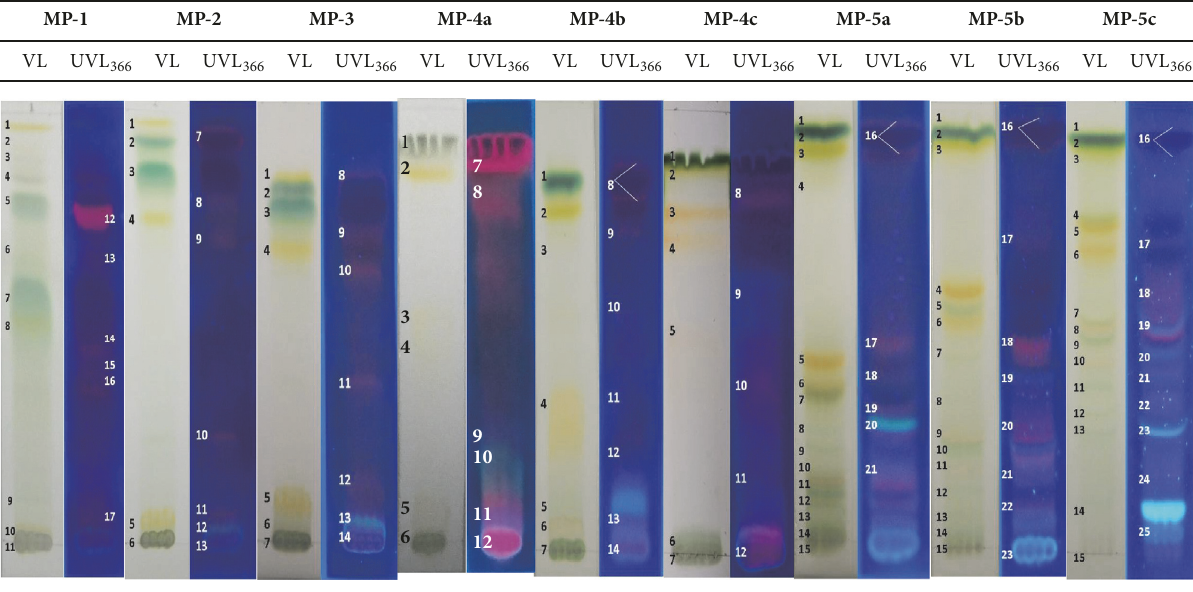
Figure 1: Representative photographs of 1D thin layer chromatograms for a methanolic extract of Spirulina platensis , developed with the indicated mobile phases and visualized under visible light (VL) or under ultraviolet light (UVL 366 ).